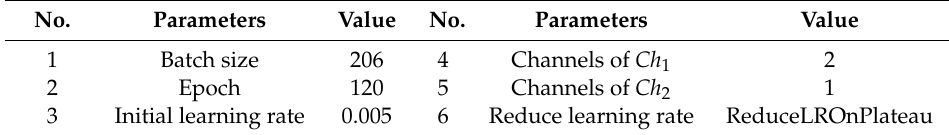
Table 5. Training parameters and values.